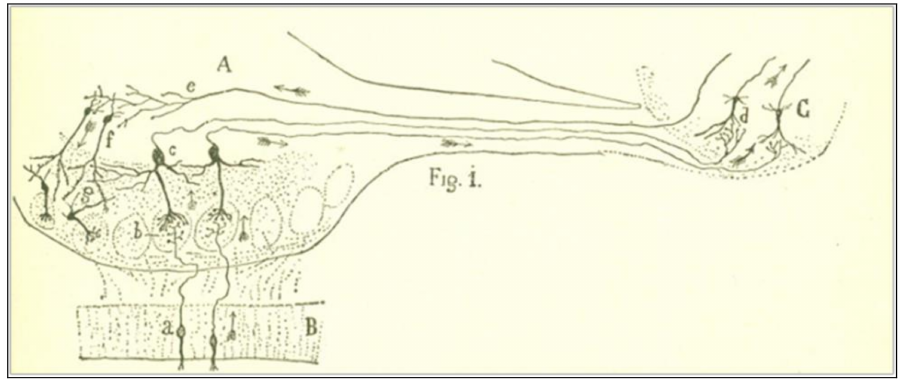
Figure 1. A scheme of the cell junctions of the olfactory mucosa, the olfactory bulb, and the olfactory lobe of the brain. The arrows represent the direction of the current. Taken from Cajal [5] (p. 4), out of copyright.